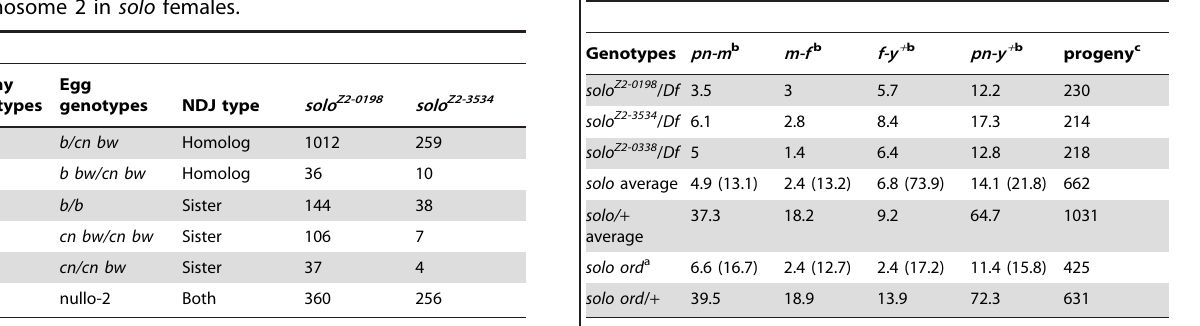
Table 3. X chromosome recombination in solo